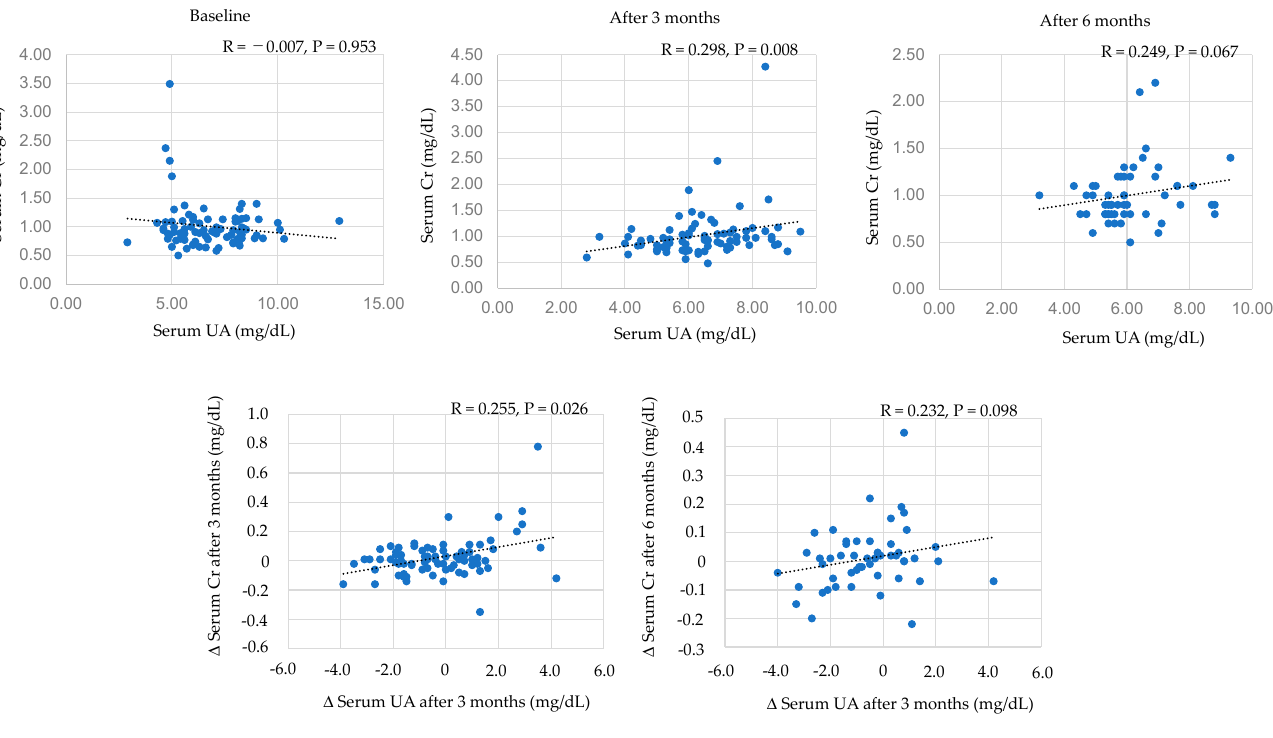
Figure 6. Correlations between serum UA and serum creatinine. Cr, creatinine.